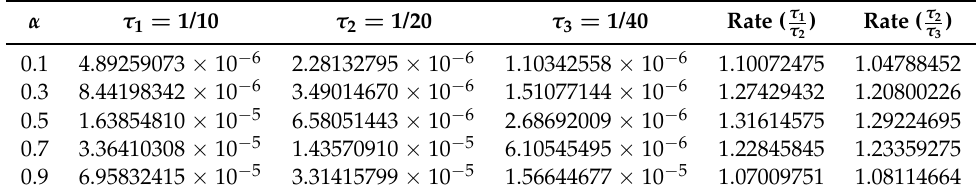
(cid:107) u ( t n ) − u n (cid:107) with h = h n